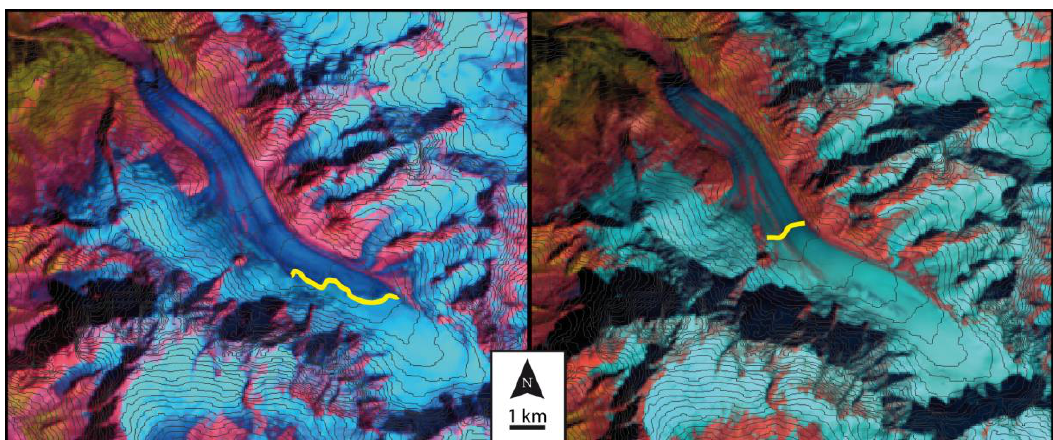
Figure 1. Examples of the snow line identification (in yellow) on the Glacier d’Argentière. The images were acquired on 18 August 2002 by Landsat-7 (left) and 9 September 2013 by Landsat-8 (right). These illustrations use a spectral band combination involving the bands #2 (0.52–0.60 μm), #4 (0.77–0.90 μm) and #5 (1.55–1.75 μm) for Landsat-7 and the bands #3 (0.53–0.59 μm), #5 (0.85–0.88 μm) and #6 (1.57–1.65 μm) for Landsat-8. Fifty-meter elevation contour lines are shown in grey.